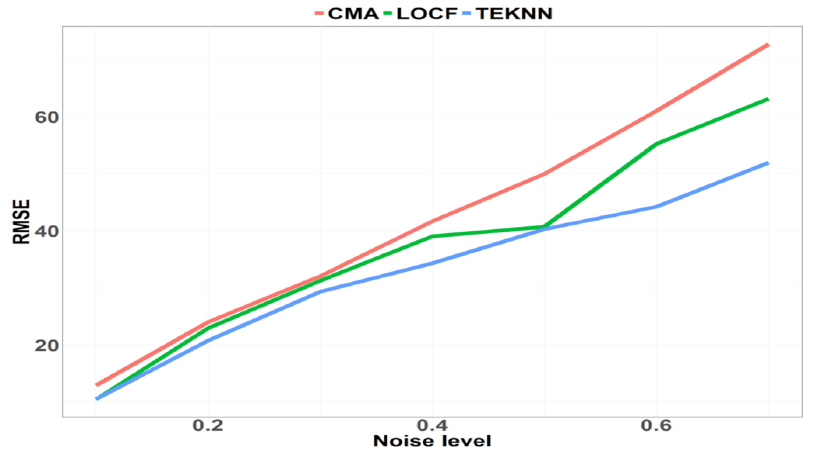
Fig 1. Imputation